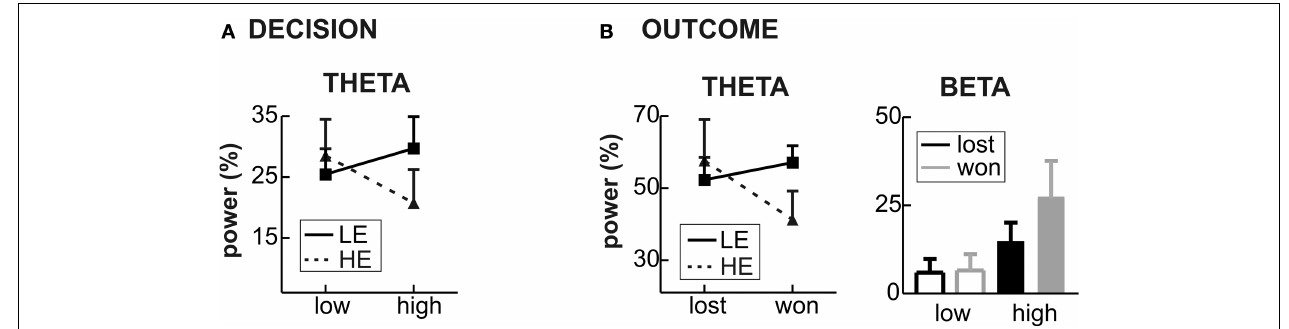
shown for the LE and HE group, revealing the relative theta decrease in won trials in the HE group and no feedback-related difference in the LE group. The right panel illustrates the mean power change for the beta band, separately for the four conditions (won and lost under high and low provocation). The highest beta increase is found in won trials under high